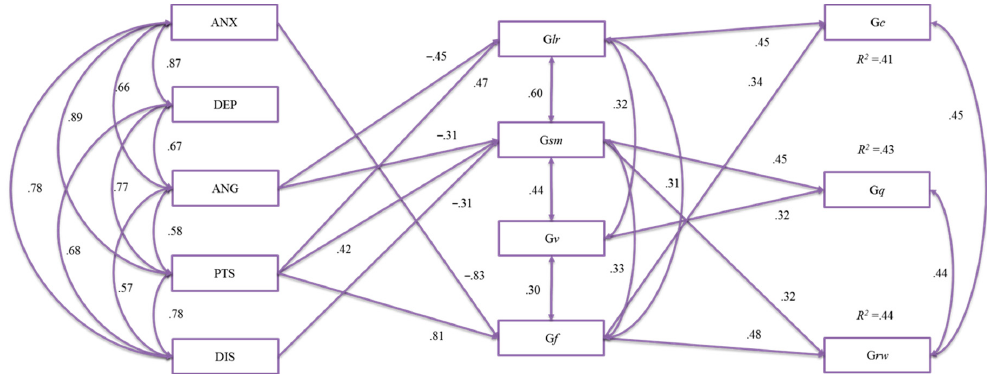
Figure A1. Exploratory path diagram from trauma symptoms to academic achievement intervened by cognitive functioning: All paths are significant ( p < 0.05). Goodness of fit indices were as follows: χ 2 (35) = 38.7, p = 0.31, CFI = 0.992, RMSEA =